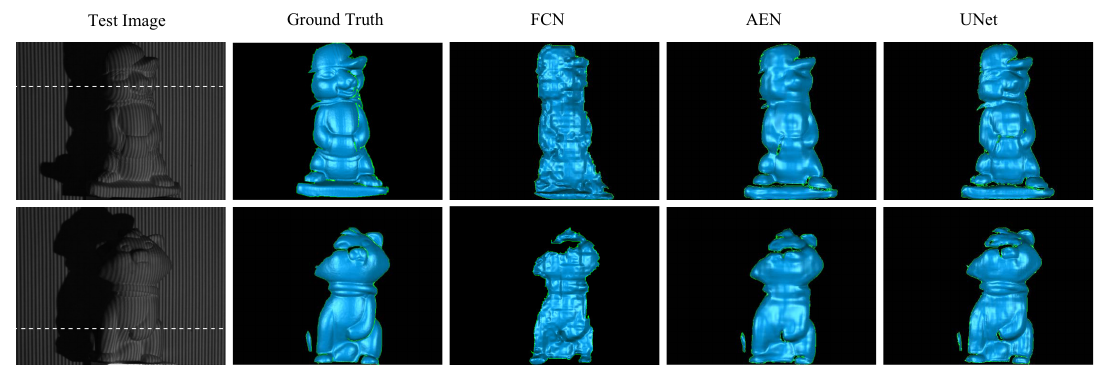
Figure 4. 3D reconstruction results of two representative test